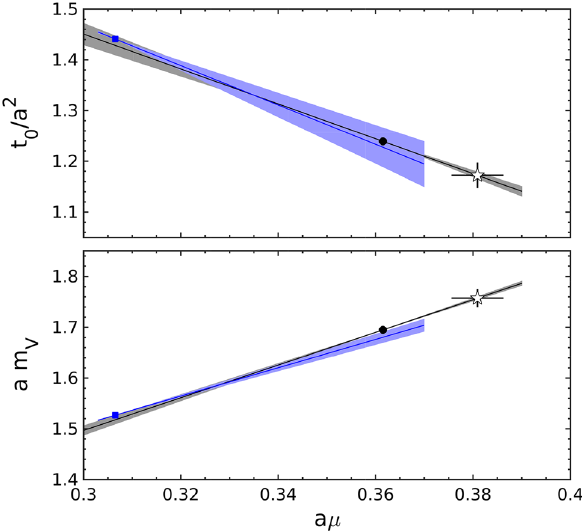
Fig. 2 The solid square and circular markers are direct simulation resultsfor t 0 / a 2 (top)and am V (bottom)onourcoarsestensembleswith β = 5 . 3. The simulations were carried out at slightly different masses, namely a μ = 0 . 36151 (circle) and a μ = 0 . 30651 (square). The lines, with their respective error bands illustrate the value and error of the derivative of the observable with respect to the twisted mass parameter. The pentagram depicts the values obtained at the tuning point Eq. (3.32) . Its vertical error bar is the complete error, including all correlations